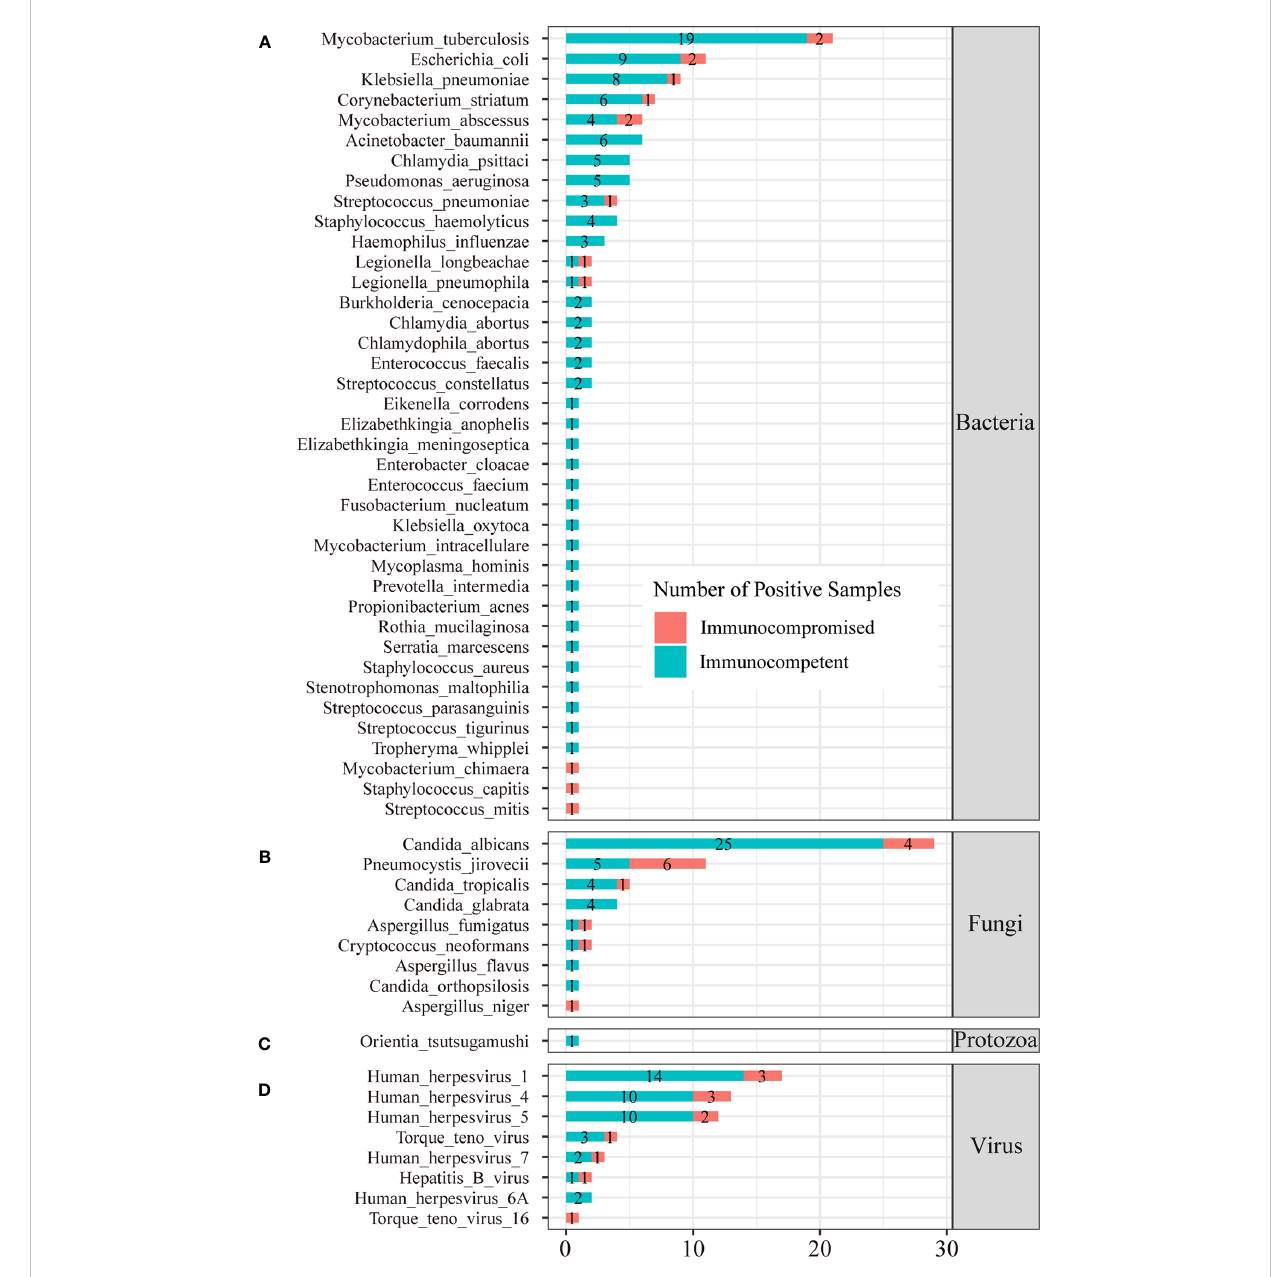
FIGURE 6 Infected pathogens detected by mNGS in immunocompetent and immunocompromised patients with severe pneumonia. (A) Bacteria levels; (B) fungi level; (C) protozoa level; and (D) virus